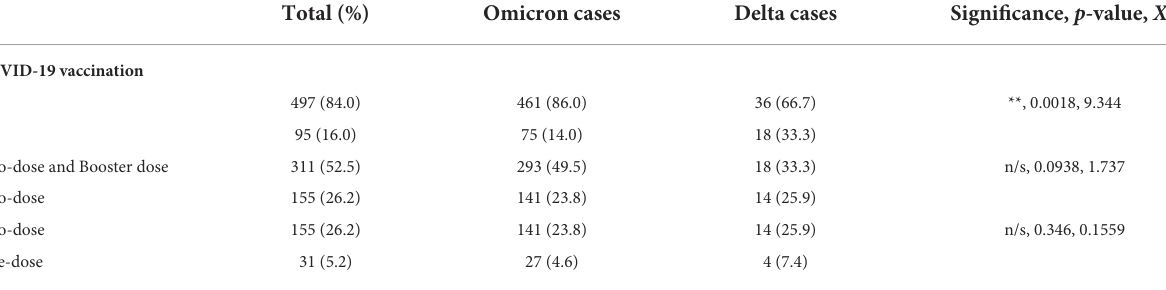
TABLE 2 Effect of each vaccination dose on the prevalence of Omicron and Delta variant infection in a cohort from Santiago of Chile. Total (%) Omicron cases Delta